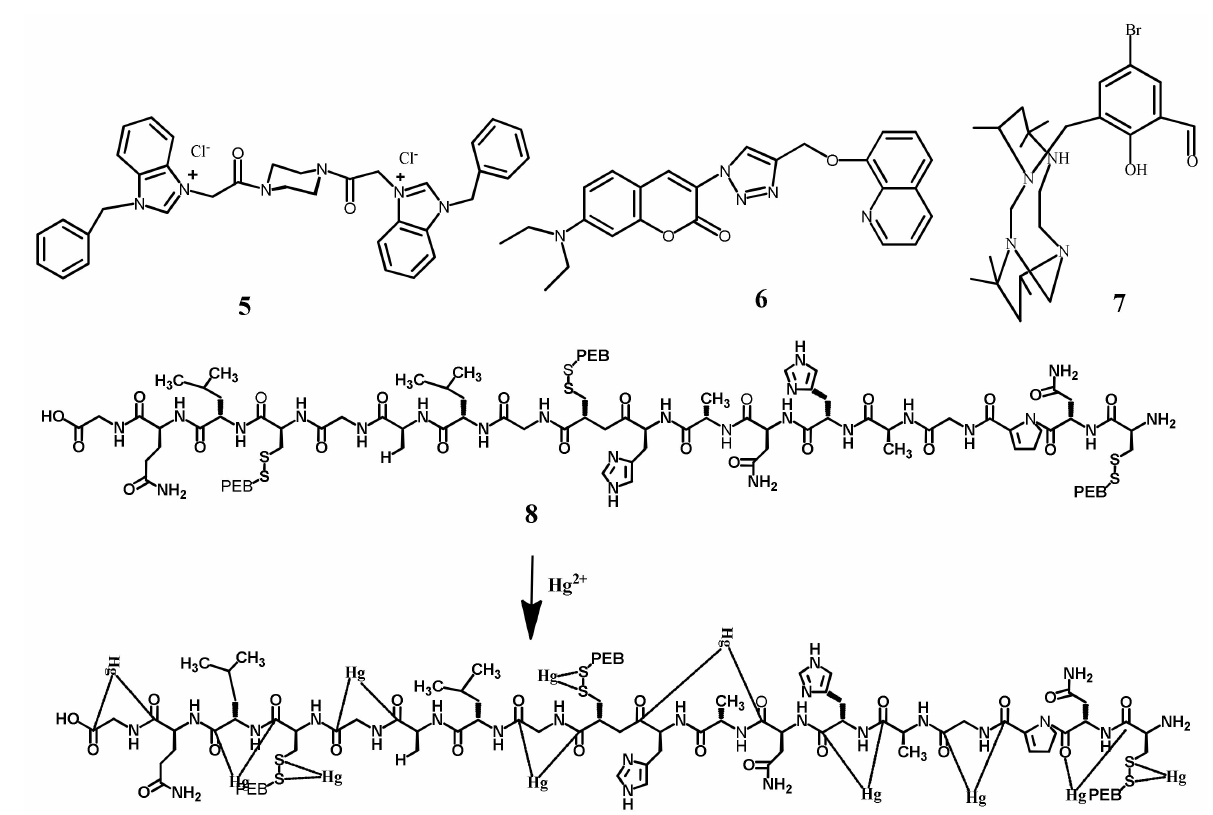
Figure 5. Molecular structures of the sensors 5 to 8